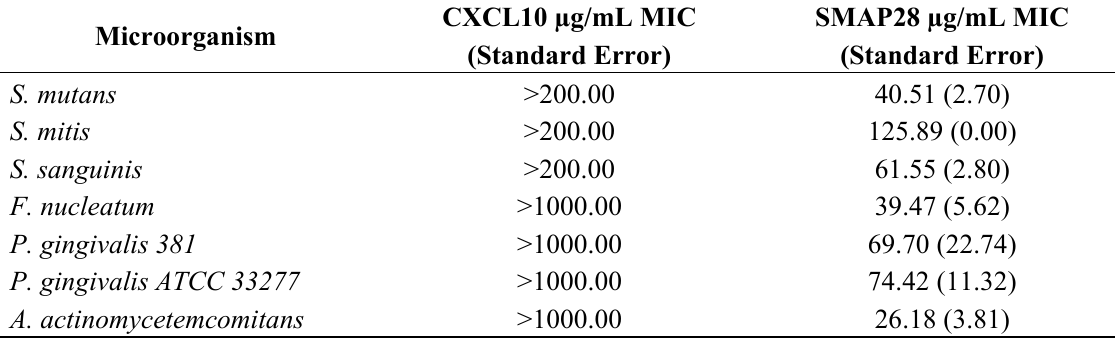
Table 3. Radial diffusion assays showing the minimal inhibitory concentration (MIC) of CXCL10 for microorganisms commonly found as commensals or pathogens in the oral cavity. Microorganism